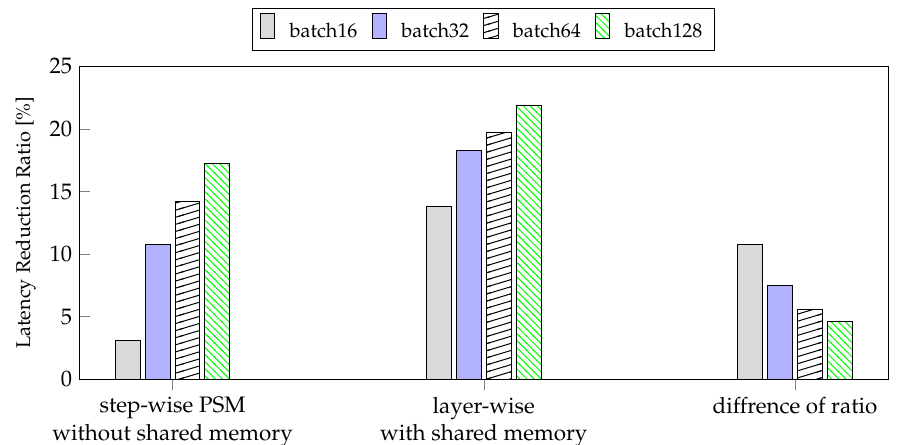
Figure 10. The result of latency reduction ratio of step-wise PSM on method without shared memory and layer-wise PSM with shared memory compared to GPU.